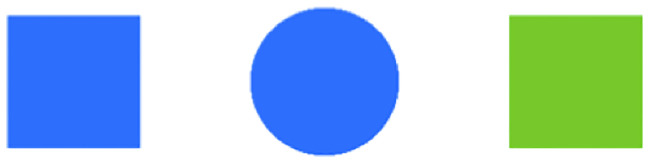
Example context type from F&G [20].